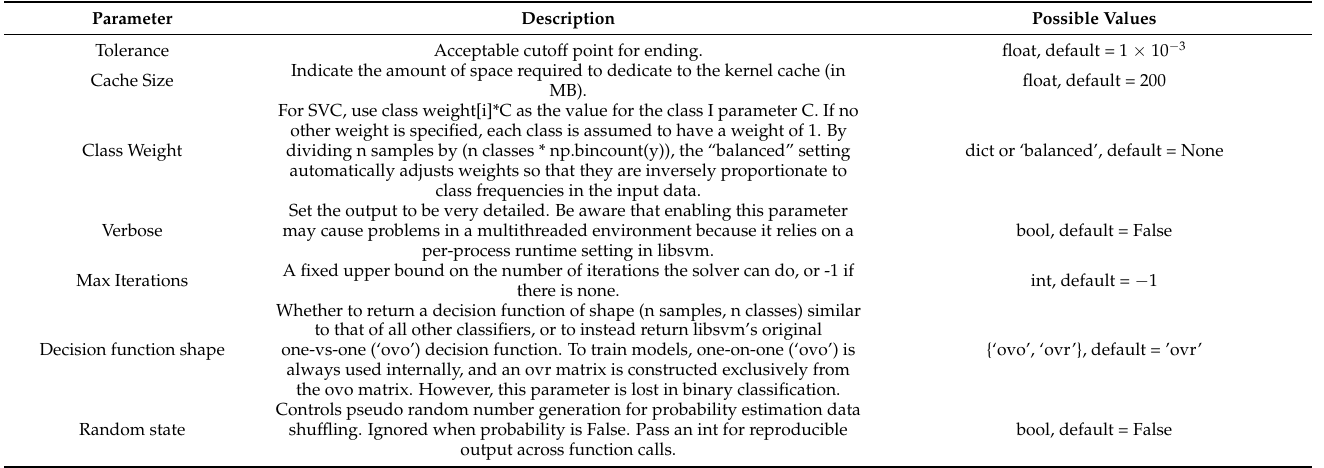
Figure 12. Performance of ACO ‐ SVM on Heart Disease . The selected best SVM parameters are shown in Table 3. Table 3. Selected best ACO ‐ SVM parameters. Parameter